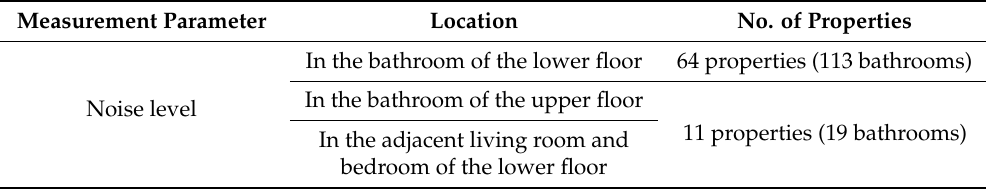
Table 6. Measured location and number of properties for each measurement